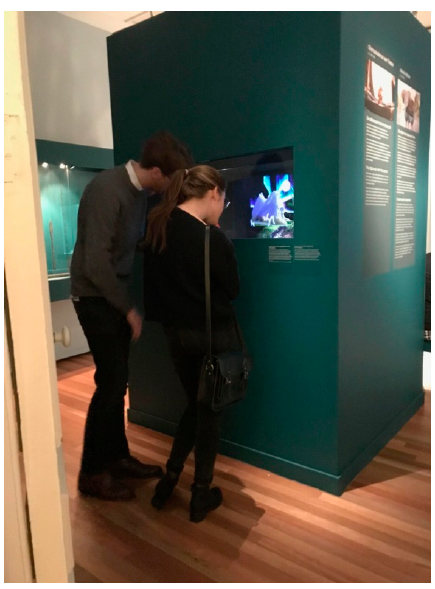
Figure 12. Holographic showcase in stand-alone version, CNR ITABC and E.V.O.CA., Allard Pierson Museum, Amsterdam, 2017–2018.